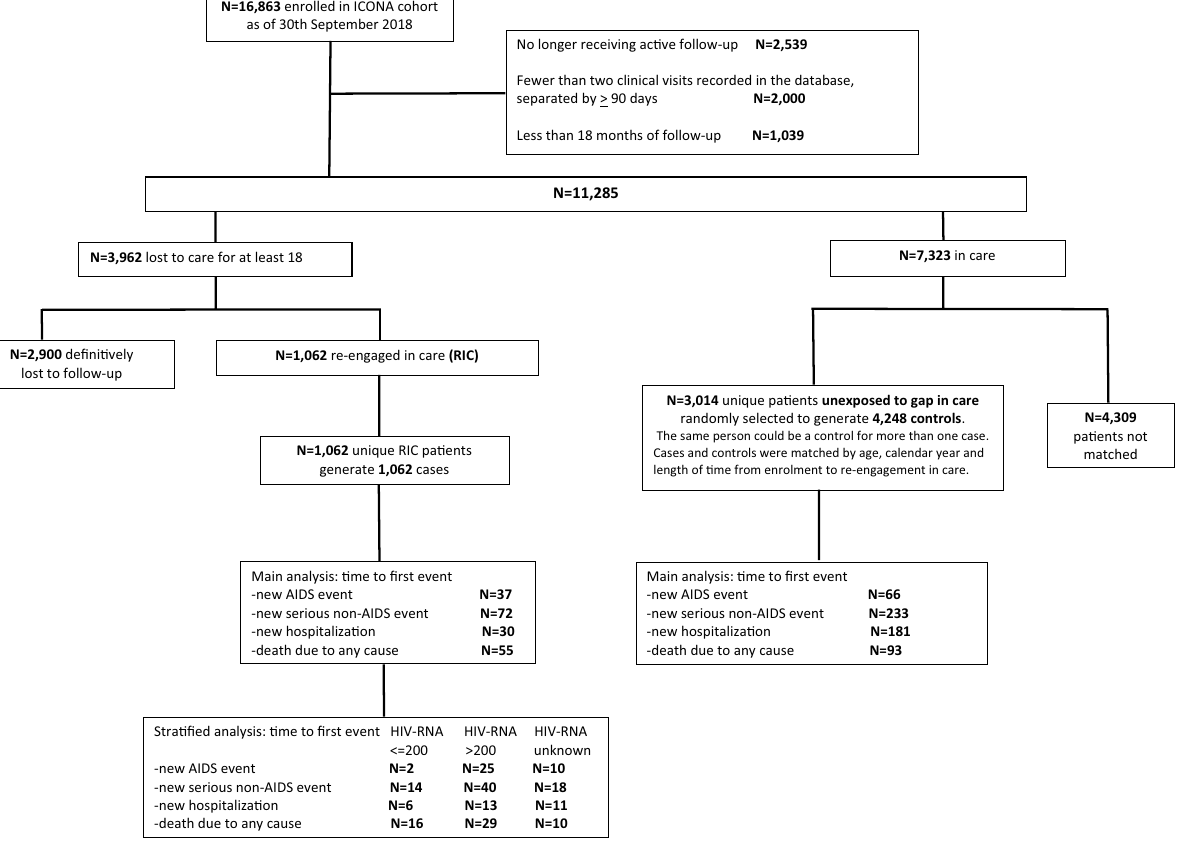
Figure 1. Flowchart of the patients’ disposition from cohort enrolment to the analysis